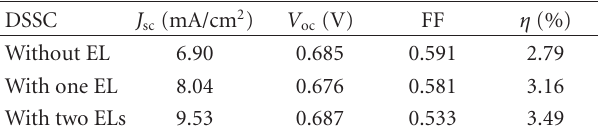
Table 1: Values for θ 1 , θ a , and θ b obtained by equations (2), (3), and (6), respectively. Data θ 1 θ a θ b Calculated 61.473 ◦